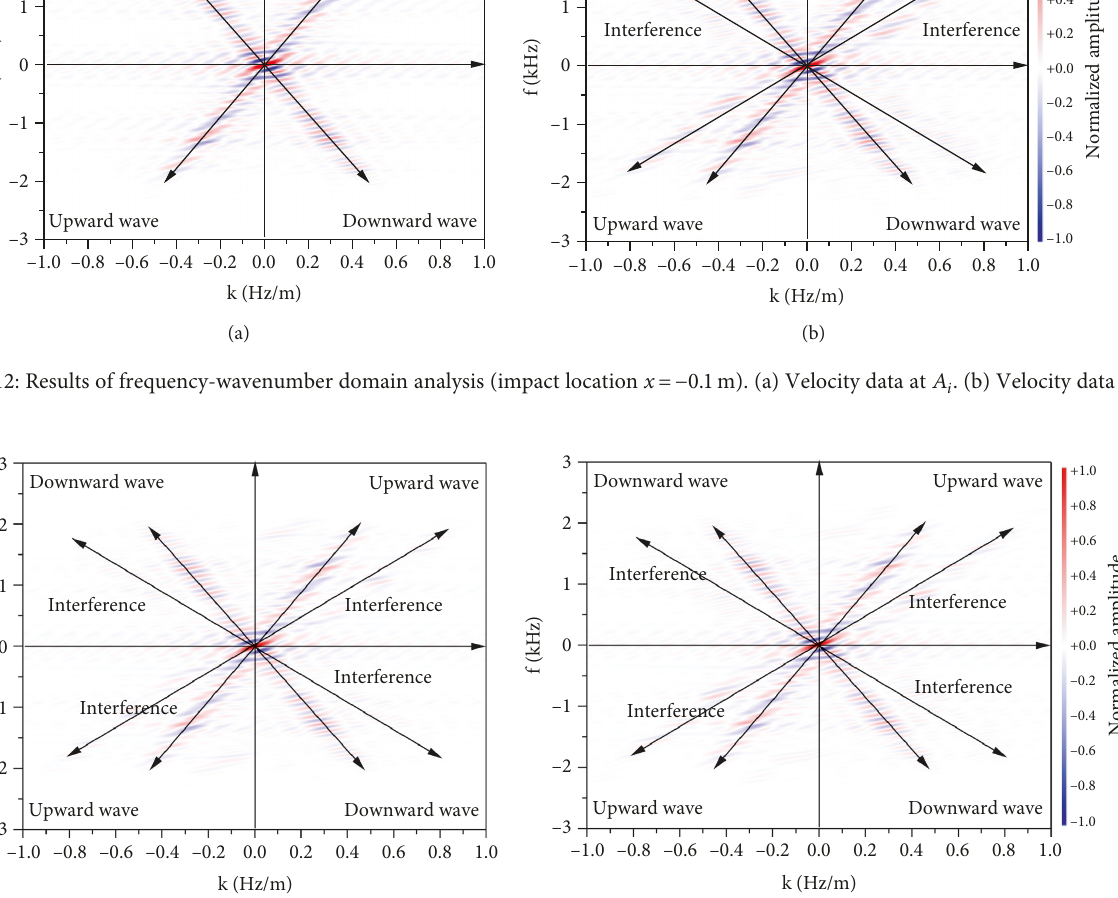
0.1m). (a) Velocity data at A i . (b) Velocity data at B i . (cid:29)